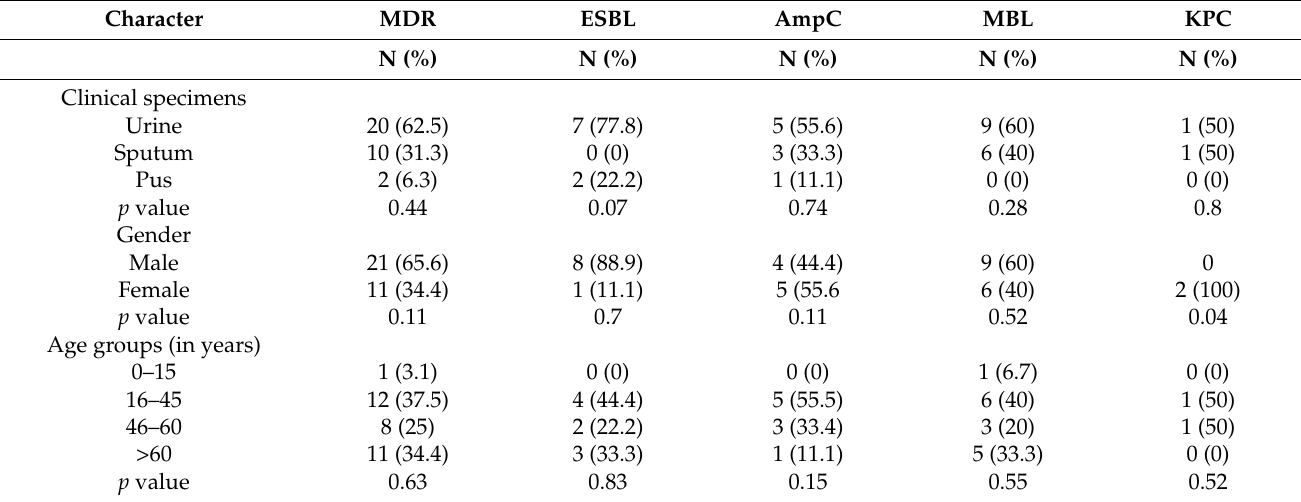
Table 4. Demographic and clinical character of MDR, ESBL, AmpC, MBL and KPC producing Klebsiella spp. according to clinical specimens, gender and age.